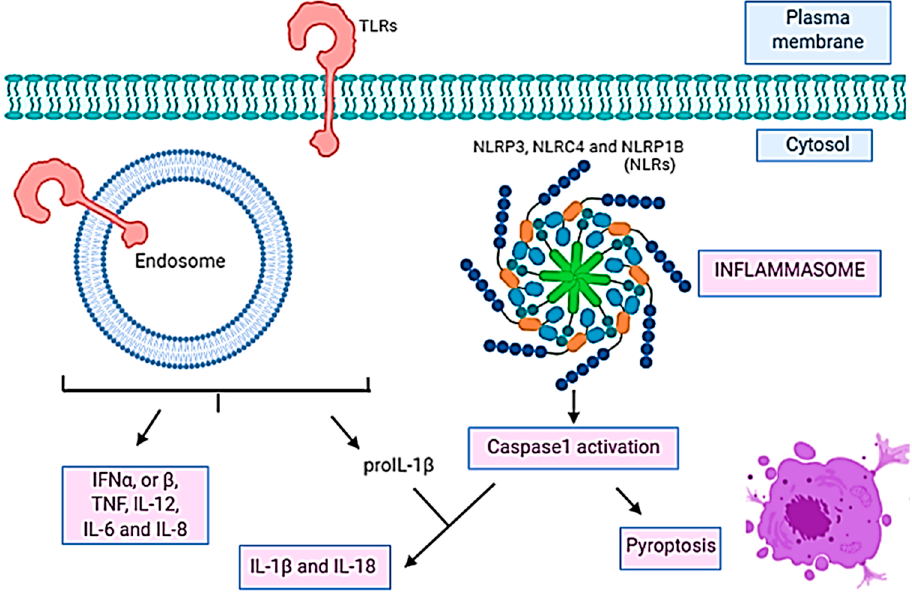
Figure 3. Pyroptosis pathway with Toll-like receptors (TLRs) and Nod-like receptors (NLRs) acting in concert (adapted from [275]). Created with Biorender.